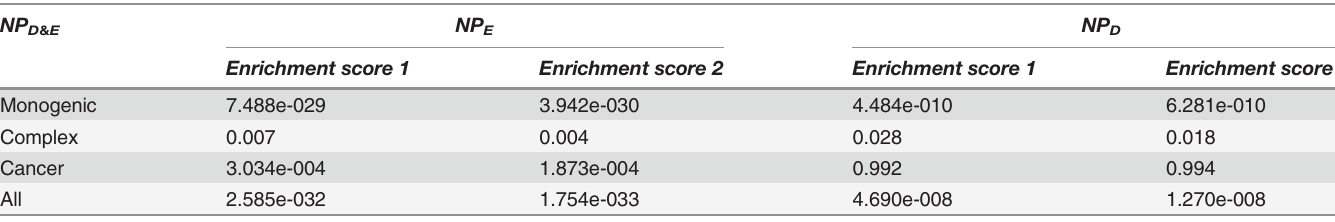
Table 7. One tailed t -Tests for Table 6: NP D & E versus Competing Approaches. NP D &